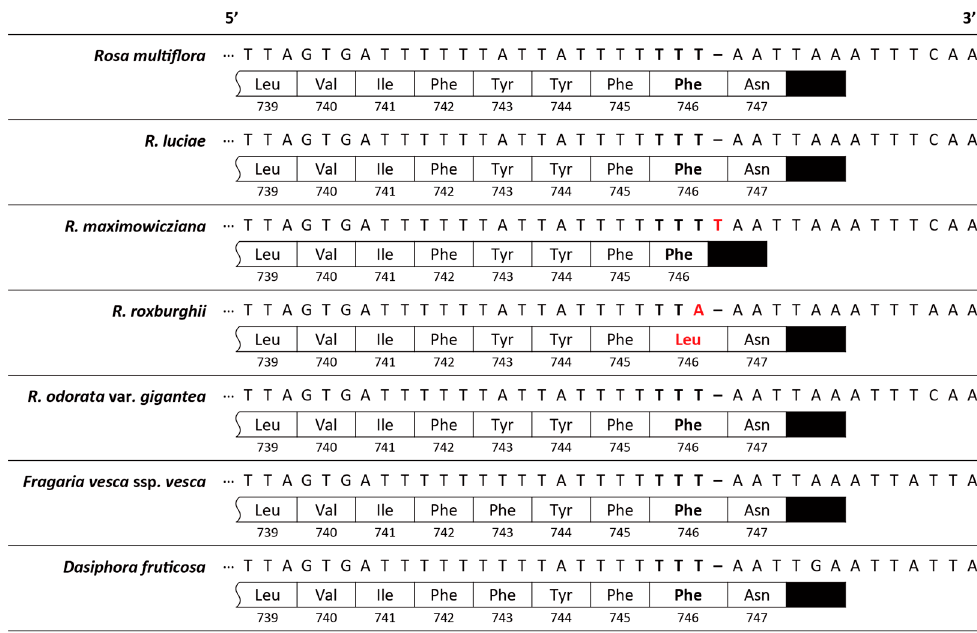
Figure 3. Pseudogenization of infA genes in the Synstylae chloroplast genomes. In each lane, aligned DNA sequence data are shown on the top. Hyphens indicate indels in the sequences. Boxed ribbons show the amino acid sequences coded from the DNA sequences, and black closed boxes indicate the terminal codons. Numbers under the boxes indicates the amino acid residue numbers. The mutated residues are bolded, and mutations are in red.